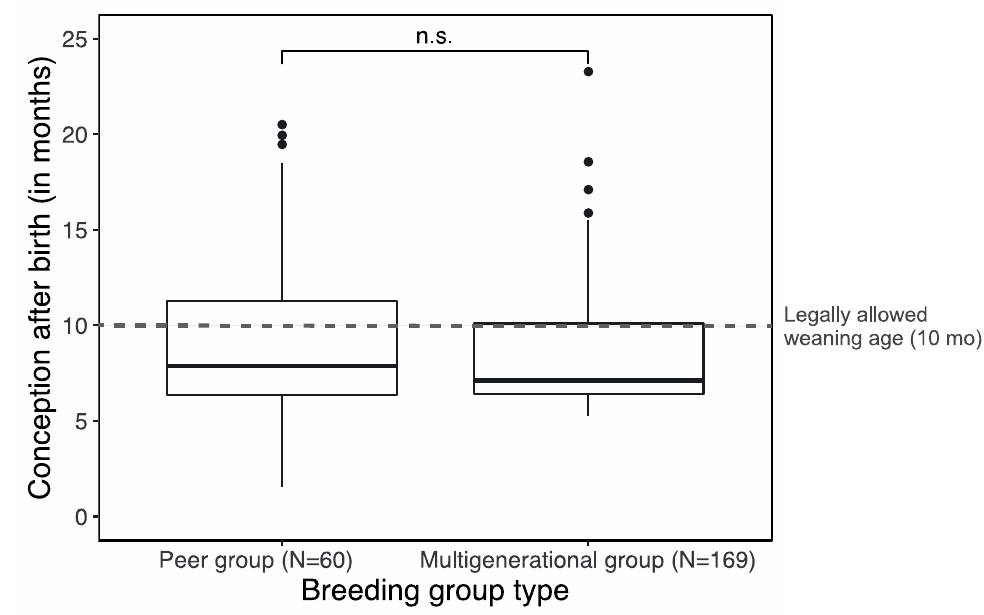
Figure 4. Females in peer and multigenerational breeding groups conceived earlier after giving birth (peer-housed females: 9.3 ± 0.5 months respectively multigenerational females: 8.6 ± 0.2 months) than the legally allowed removal age norm of ten months for transferring dependent offspring to peer groups in captive rhesus macaques. Note that the data from this figure are derived from Figure 2b.